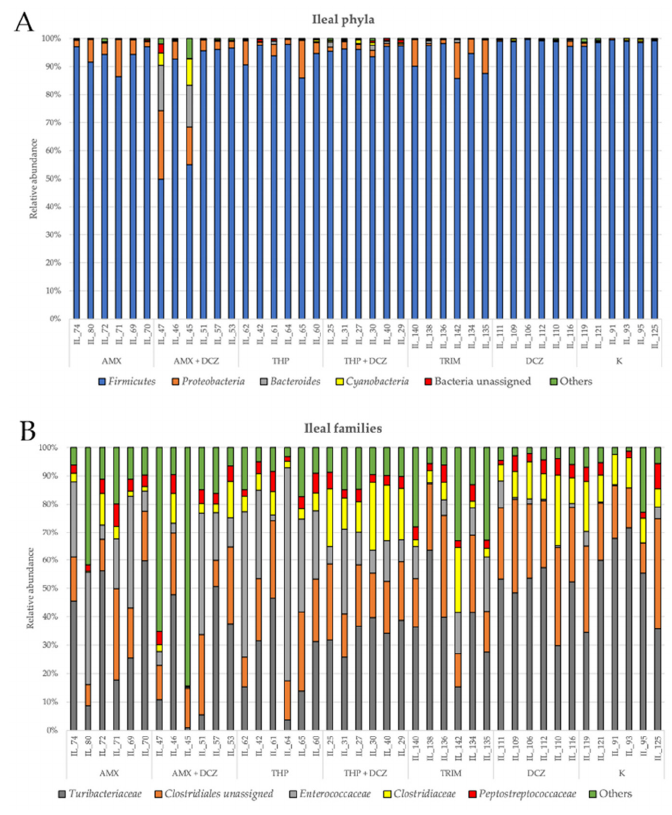
Figure 4. Relative abundance at the phylum ( A ) and family level ( B ) in ileum. Specific legends are reported for each bar plot. Table 1. p -Values summary from two-way ANOVA analysis of the top five phyla and families in caecal and ileal samples.